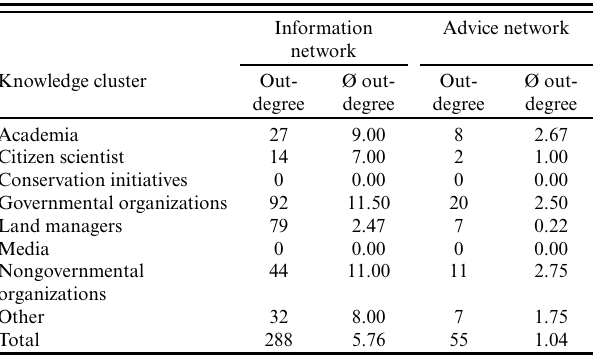
Table 5. Comparison of out-degree (number of outgoing